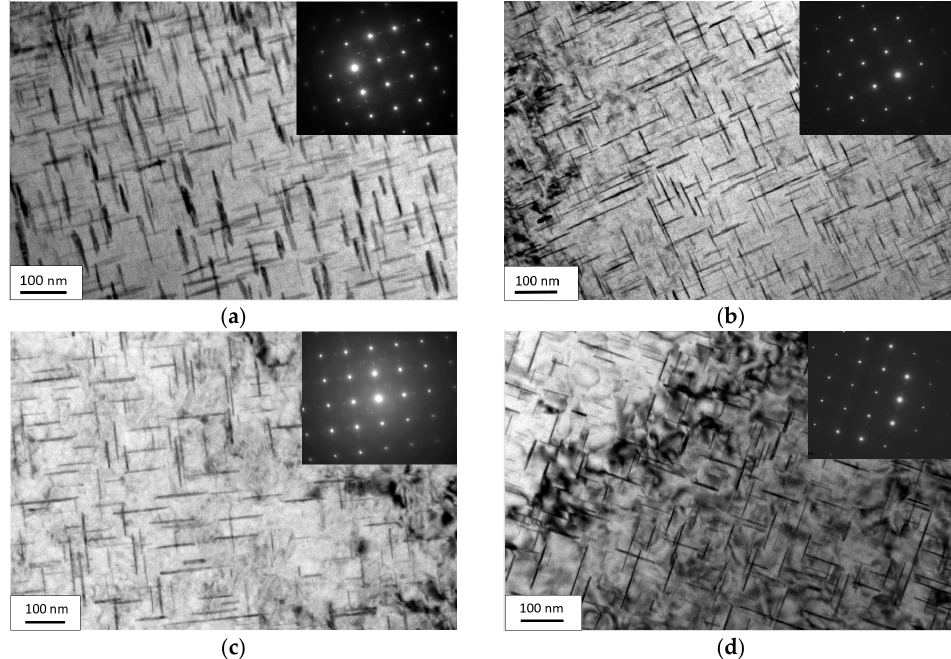
Figure 2. Transgranular TEM photo of 2219 aluminum alloy with or without EPC under the stress relaxation aging: ( a , c ) conventional stress relaxation aging of 150 and 210 MPa; ( b , d ) electric pulse stress relaxation aging of 150 and 210 MPa.